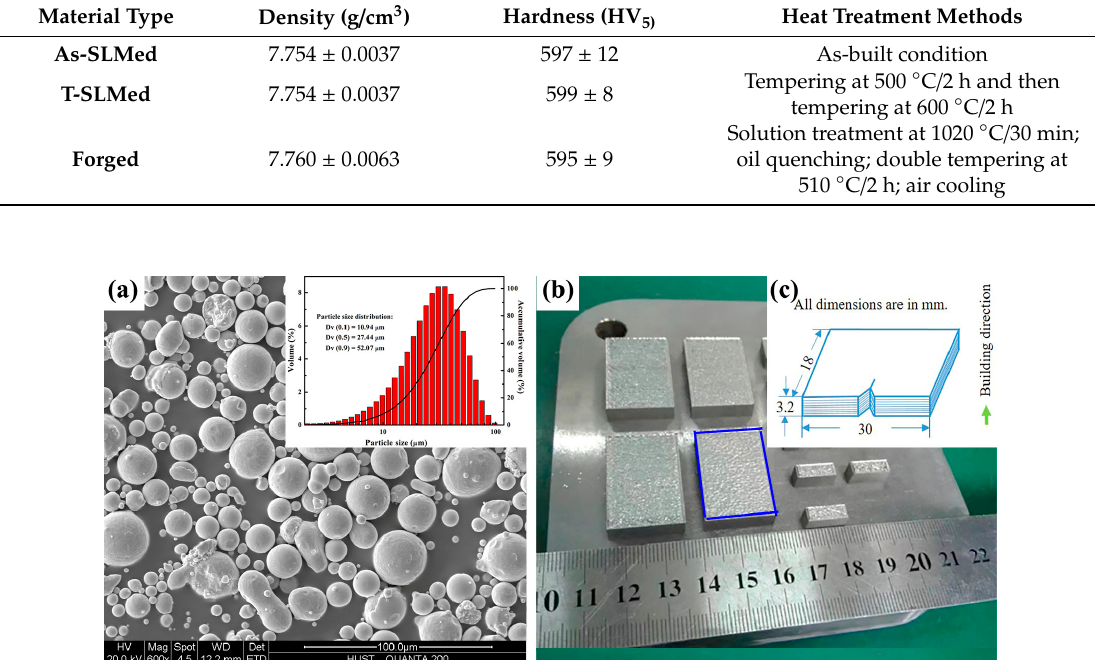
Figure 1. ( a ) Powders for the selective laser melting (SLM) process. ( b ) Bulk materials after the SLM process. ( c ) The profile of specimens for thermal fatigue (TF) tests. Table 2. Experimental work data of the used materials.